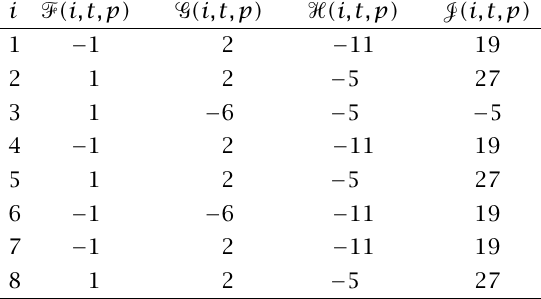
(cid:10) φ( − 1 ),φ(t),φ( 1 − t)